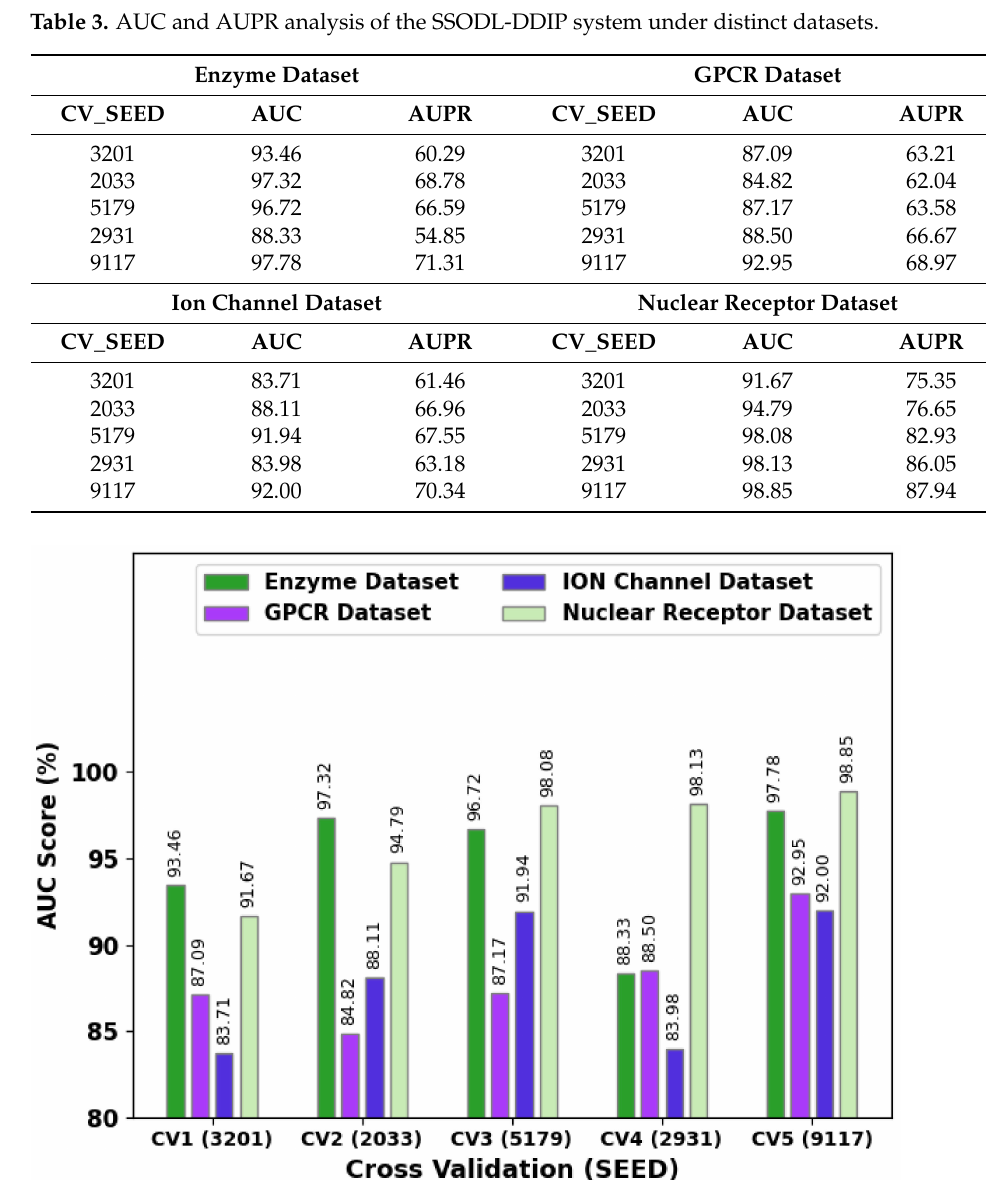
Figure 5. AUC analysis of the SSODL-DDIP technique under different CV_seed